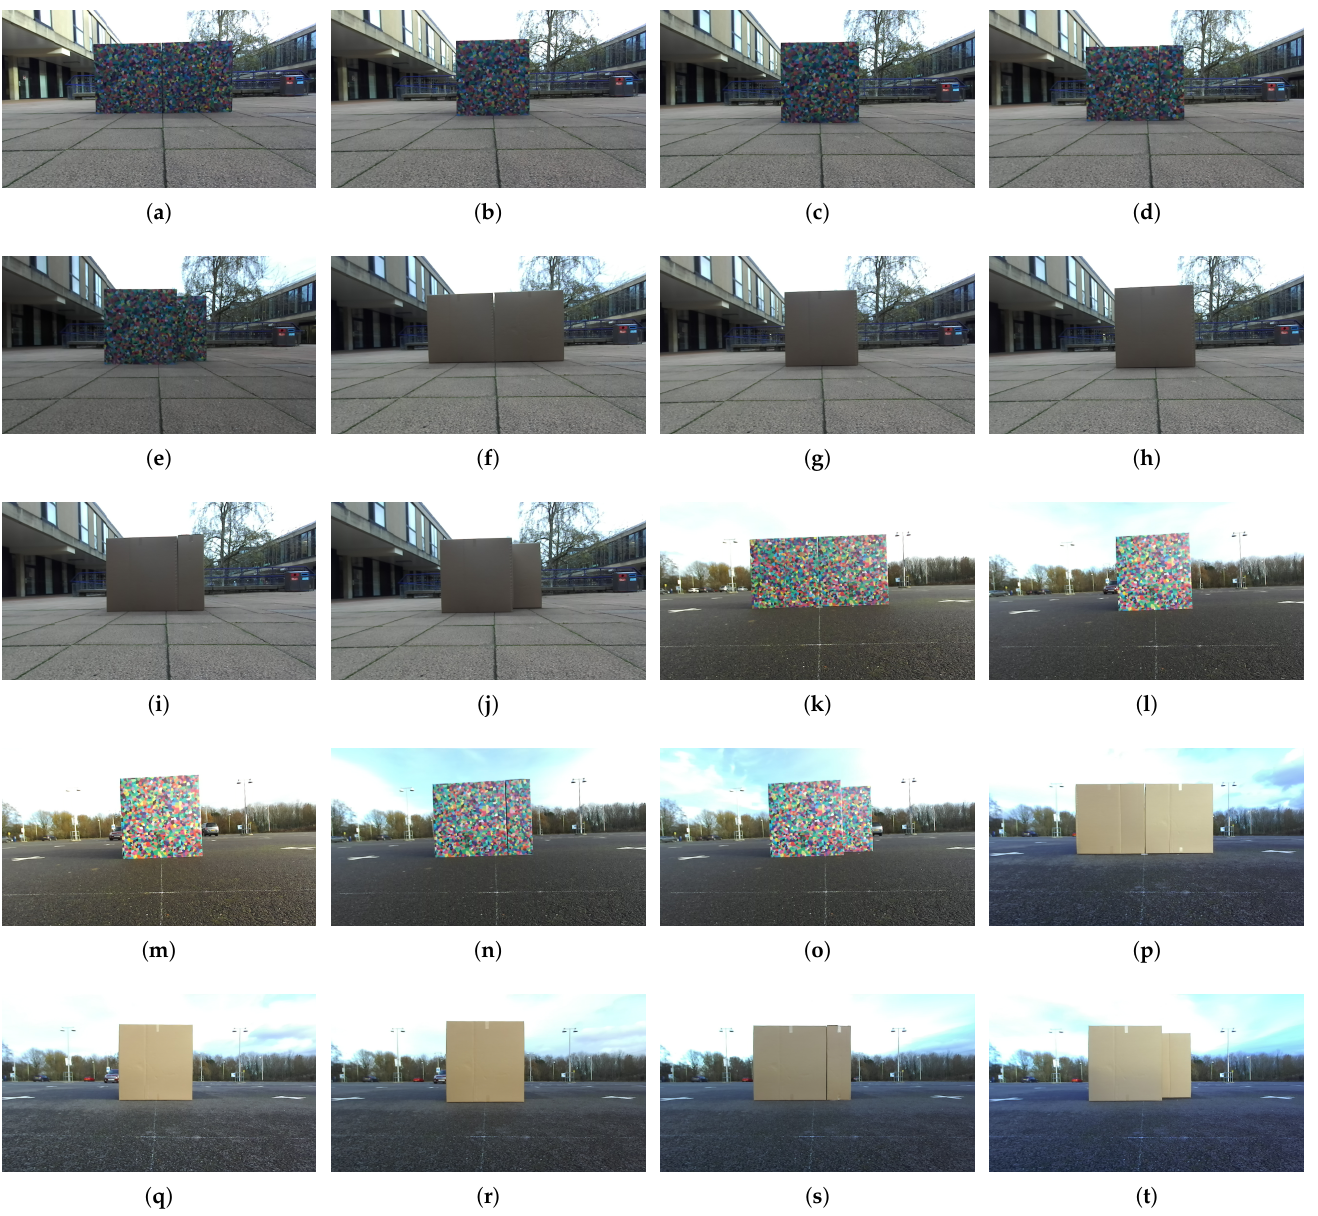
Figure 2. Boxes of five layouts and two textures in two environments. ( a – e ) I, O, T, L and S layout boxes with Voronoi diagrams in front of buildings. ( f – j ) I, O, T, L and S layout plain boxes in front of buildings. ( k – o ) I, O, T, L and S layout boxes with Voronoi diagrams in the parking lot. ( p – t ) I, O, T, L and S layout plain boxes in the parking